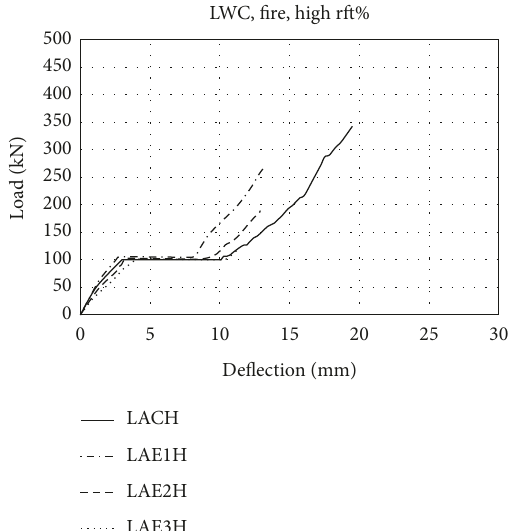
Figure 9: Effect of e / t ratio on the load-deflection curves for LWC with high RFT% when exposed to fire.